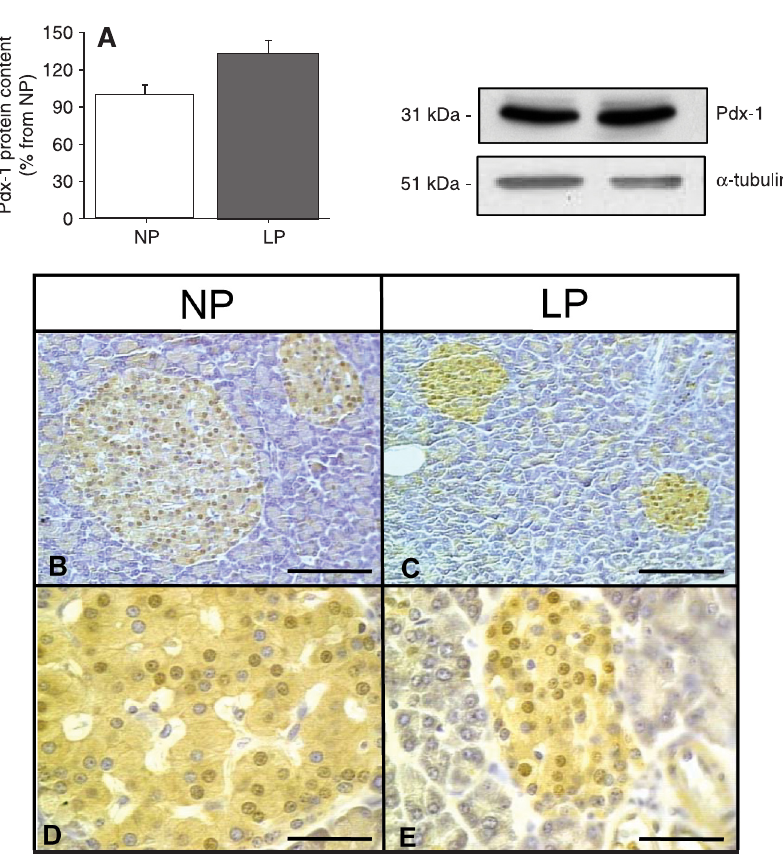
Figure 4. Protein content of pancreatic-duodenal homeobox 1 (Pdx-1) in pancreatic islets from rats receiving a normal-protein diet (NP) and a low-protein diet (LP) (A). A representa- tive control blot for α-tubulin is shown on the right side of panel A . The bars are means ± SEM for 5 independent experiments. * P < 0.05 compared to NP (Student t- test). Panels B and C show representative images of pancreatic sections stained for Pdx-1 and hematoxy- lin, showing the wide distribution of Pdx-1 in pancreatic islets from both groups. Note the similar Pdx-1 protein distribution in NP and LP islets (D, E). Scale bars = 100 µm for B, C and 45 µm for D,